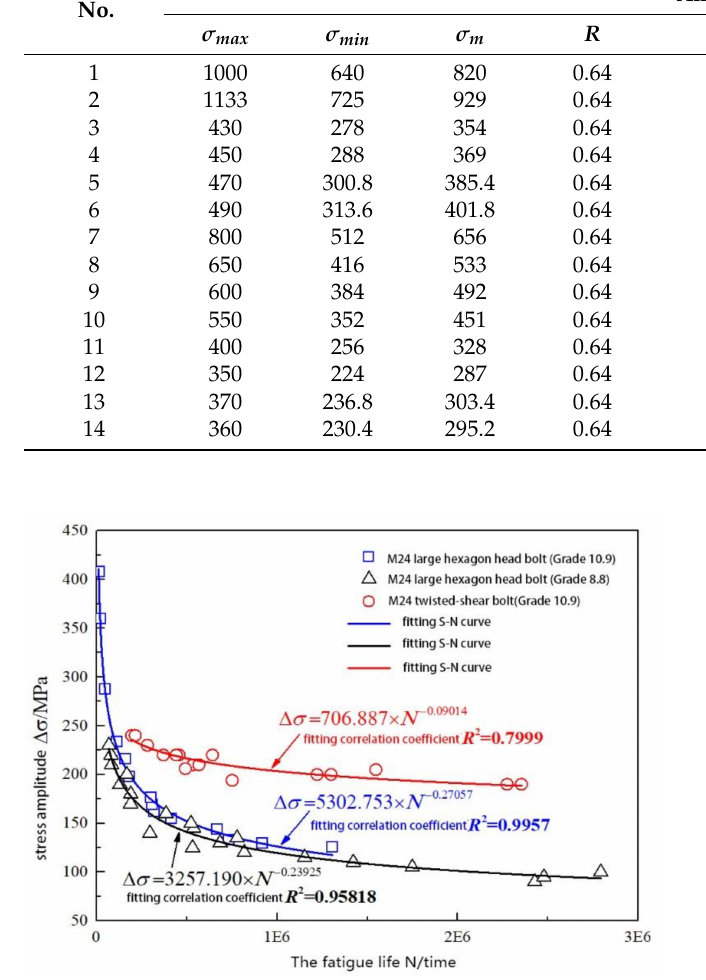
Figure 10. Comparing fatigue test results of three bolts.